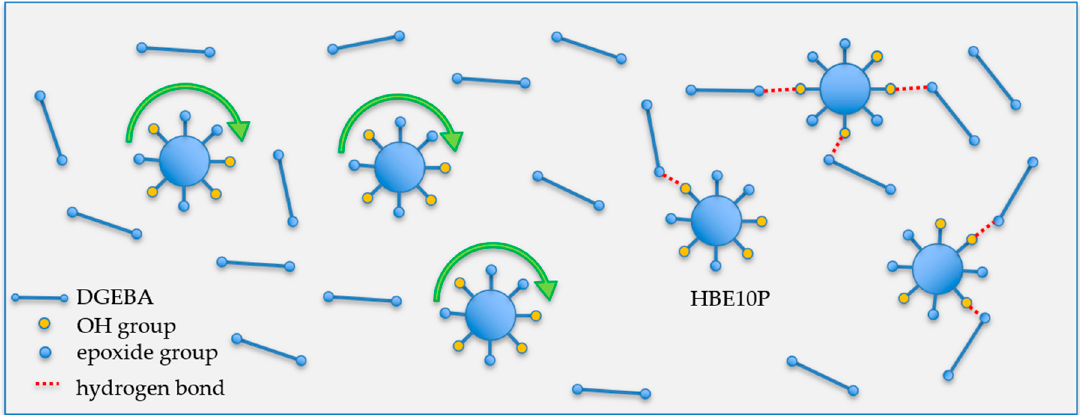
Figure 6. The effects of ball-bearing, globular and non-entanglement structure, and hydrogen bonds on the epoxy system.